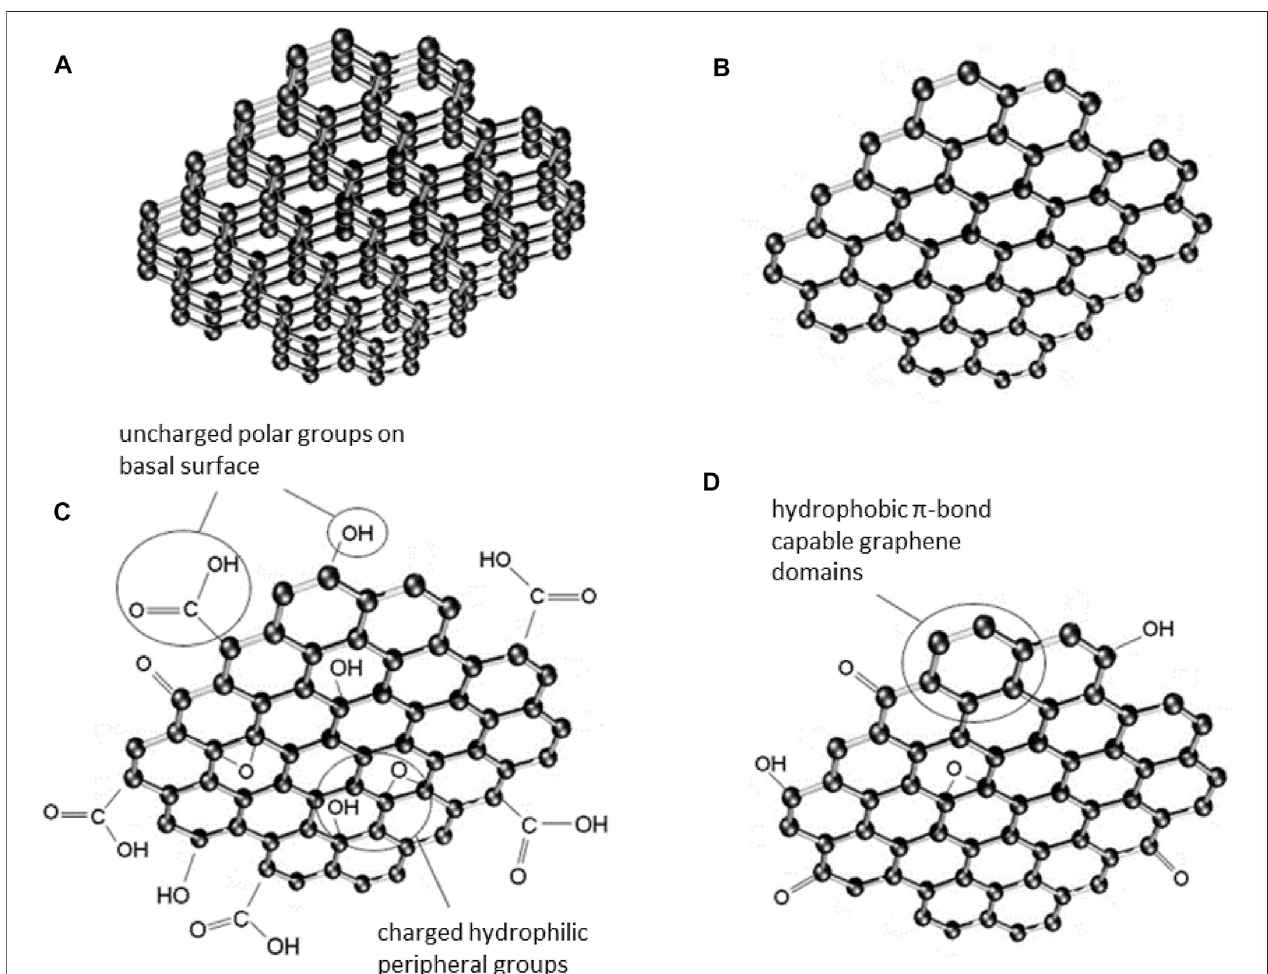
FIGURE2| Schematicofthe graphene-family nanomaterials(GFMs) structures such asmultilayered graphene fl ake (A) ,graphenesheet (B) , graphene oxide (GO) (C) and reduced graphene oxide (RGO) (D) . For simplicity, the structures (C , D) are presented in a form of carbon monolayers (Reproduced with permission from (Jastrze ˛ bska et al., 2012)).